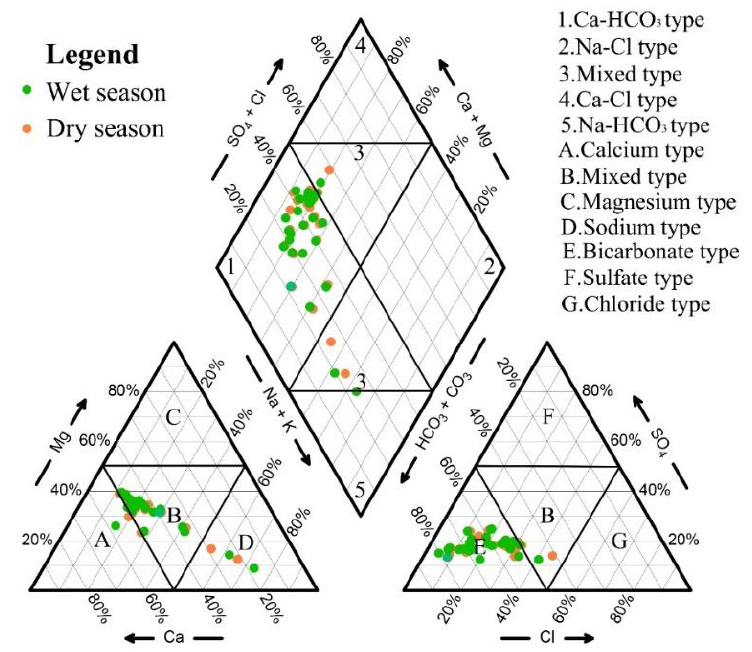
Figure 3. The Piper diagram of groundwater in the study area.